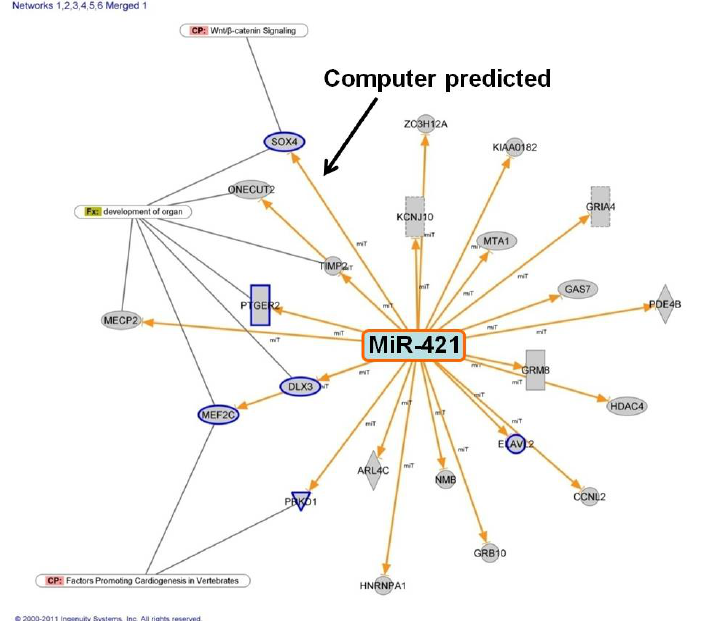
Figure 3. Putative connections between miR-421 and genes associated with cardiac development or function with significant inverse correlations between expression in TOF RV relative to control RV. Genes with a blue outline are members of the 5 key cardiac regulatory pathways shown in Figure 1 in